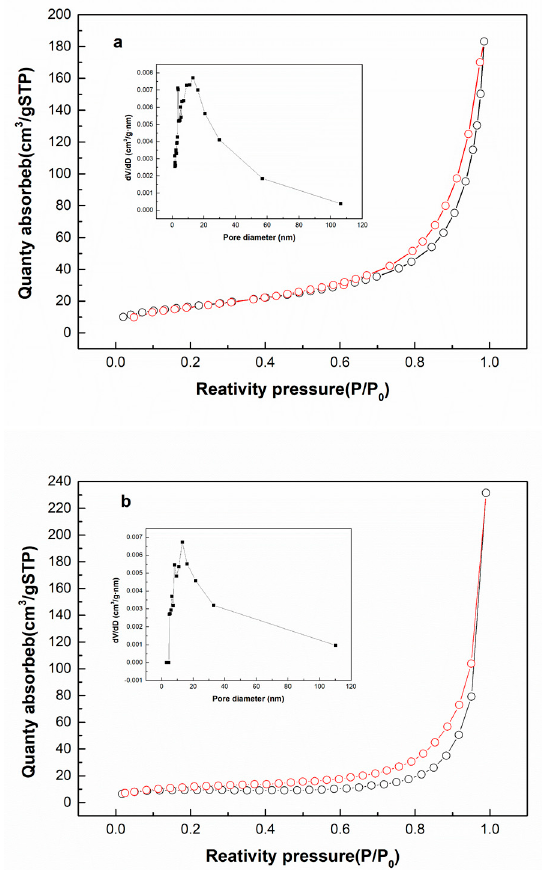
Figure 3. N 2 adsorption–desorption isotherms of ( a ) SC and ( b ) Lip–Glu–A-SC. The insets to part ( a ) and ( b ) were the pore size distribution.